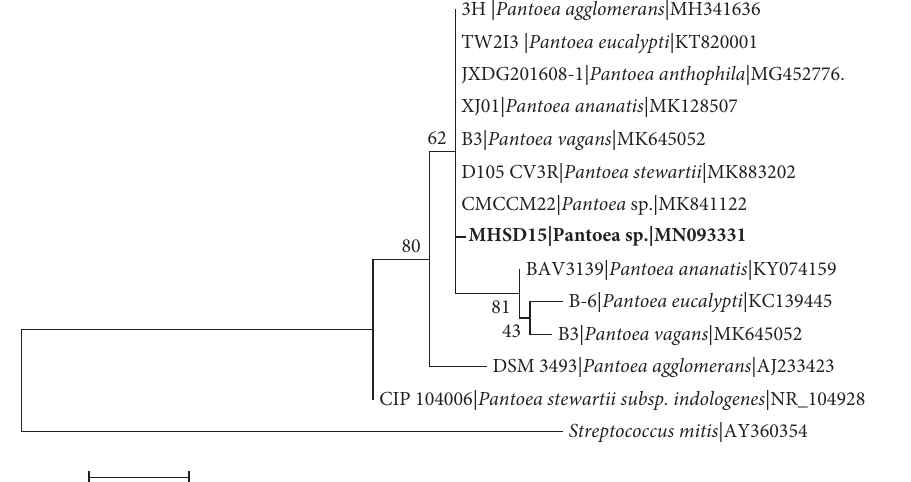
Figure 4: Maximum likelihood phylogenetic tree based on analysis of partial 16S rDNA nucleotide sequences of Pantoea sp. strain MHSD15 with related strains from Pantoea genus. Numbers above or below the nodes indicate bootstrap values generated after 1000 replications. Streptococcus mitis (AY360354) was used as an outgroup.